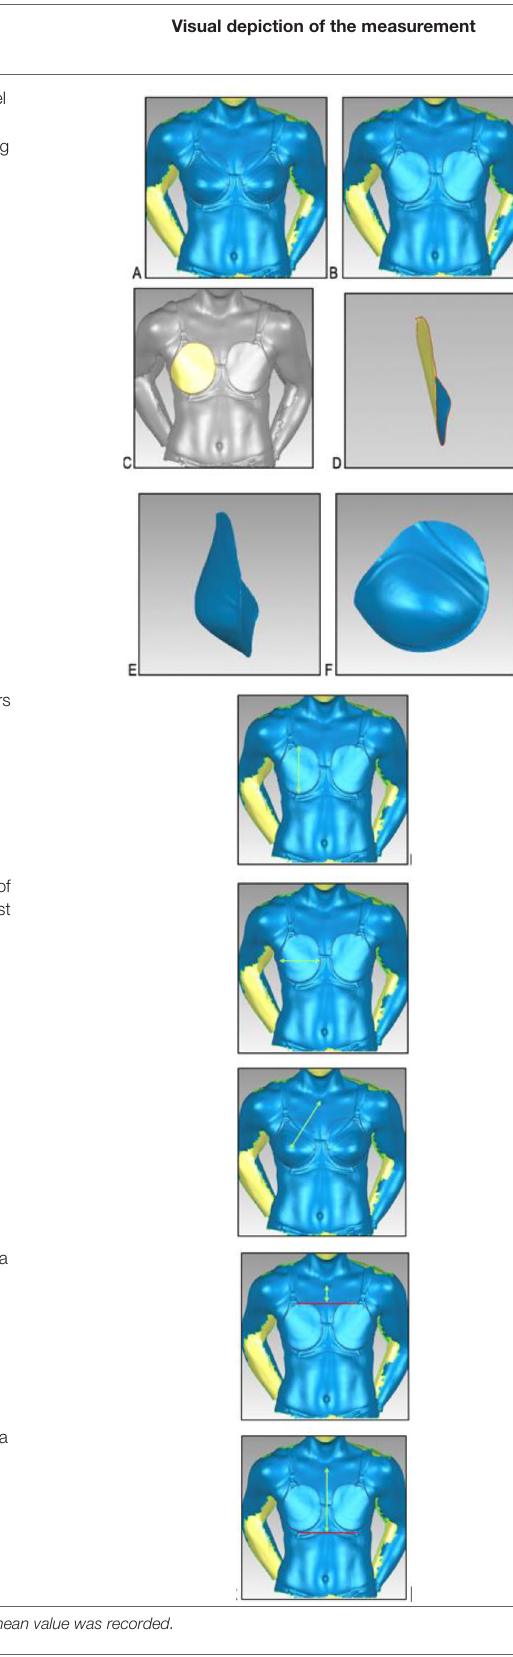
Visual depiction of the